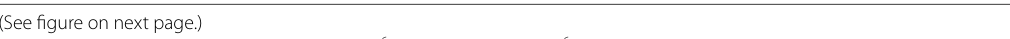
Fig. 2 The dynamic and reversible process of m 6 A modification. The m 6 A modification can be installed by the multicomponent m 6 A methyltransferases complex (writers) which includes METTL3, METTL14, WTAP, VIRMA, RBM15/15B, ZC3H13 and CBLL1, as well as independent RNA methyltransferases such as METTL16, METTL5, ZCCHC4, and removed by demethylases (erasers) FTO and ALKBH5. Various binding proteins (readers) can then recognize the m 6 A modification to perform specific biological functions. In the nucleus, m 6 A can be identified by YTHDC1, HNRNPC/G, HNRNPA2B1, YTHDF2 and FMRP, and is involved in RNA alternative splicing, nuclear RNA processing, R-loop degradation, and RNA export. In the cytoplasm, m 6 A can be identified by YTHDF1/2/3, YTHDC2, IGF2BPs, eIF3, FMRP and PRRC2A, and regulates RNA stability,